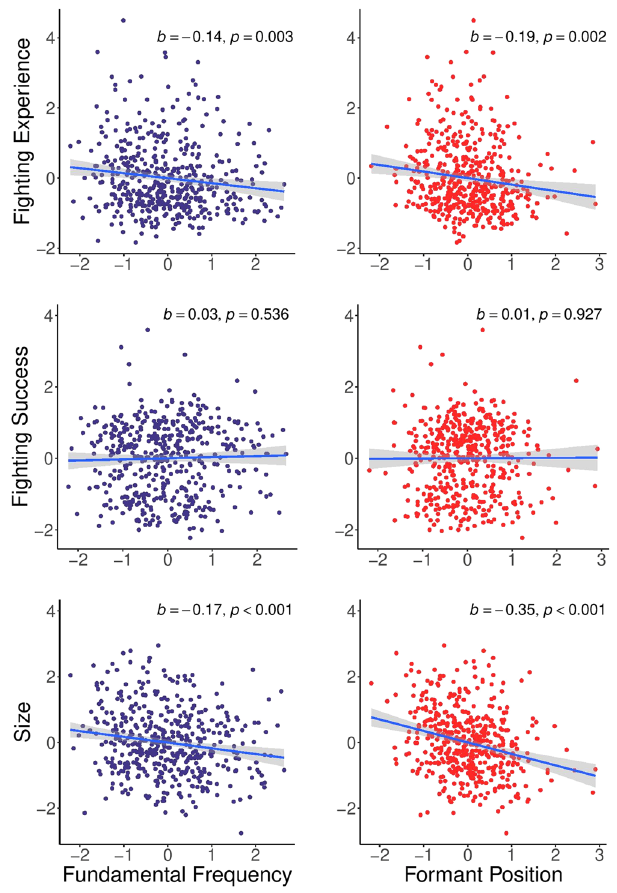
Experience (top row), Fighting Success (middle row), and Size (bottom row).